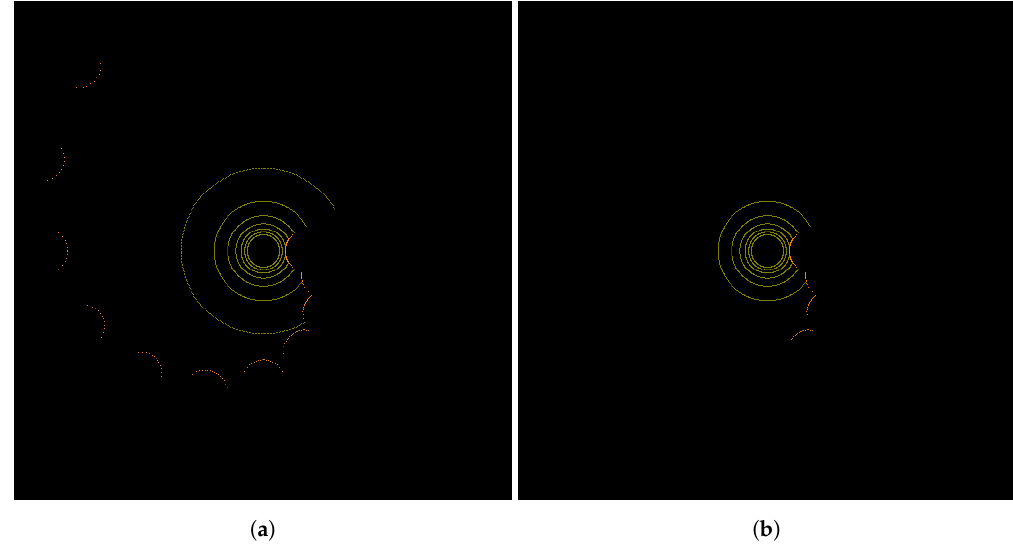
Figure 3. ( a ) Top down view of the LIDAR point cloud in the range test in clear conditions ( b ) When raining (R = 17 mm/h).